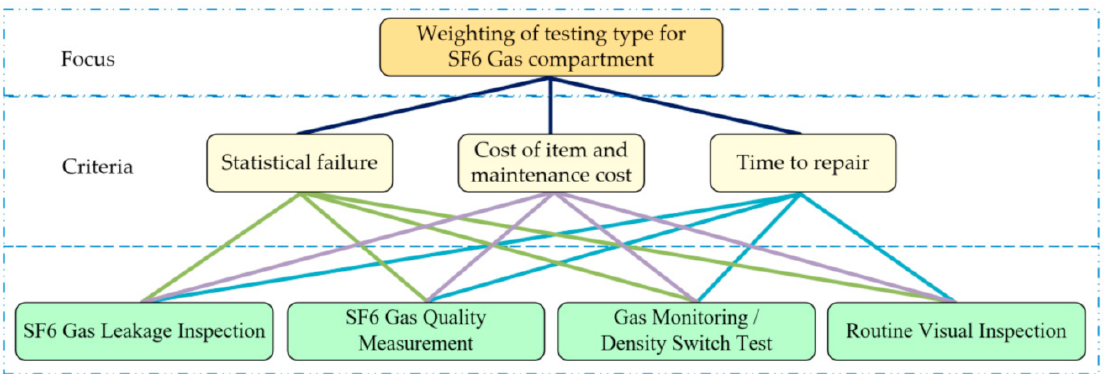
Figure 3. Analytic hierarchy process for weighting determination of field-testing of gas